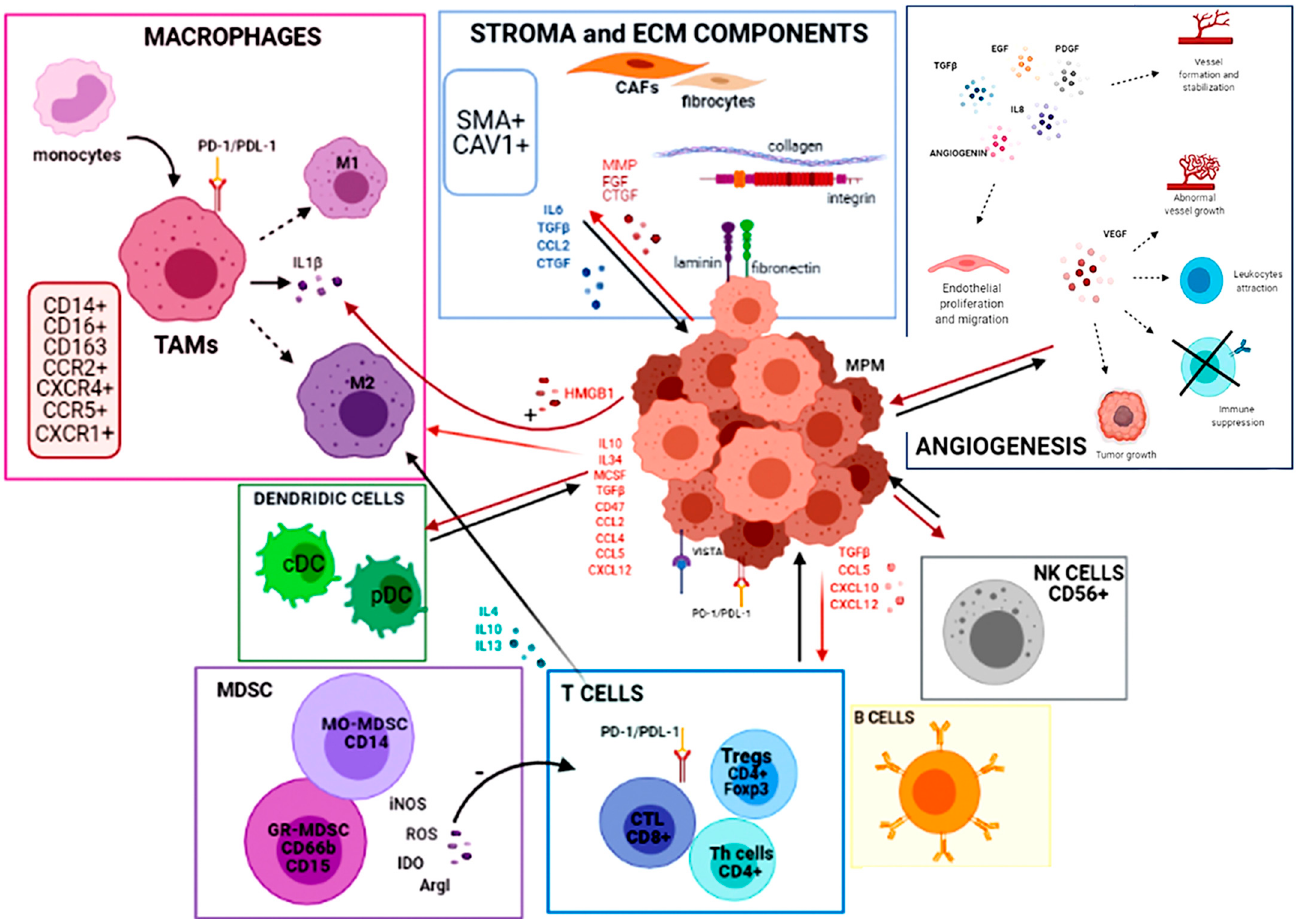
Figure 2. Graphical representation of tumor immune microenvironment interactions in MPM.